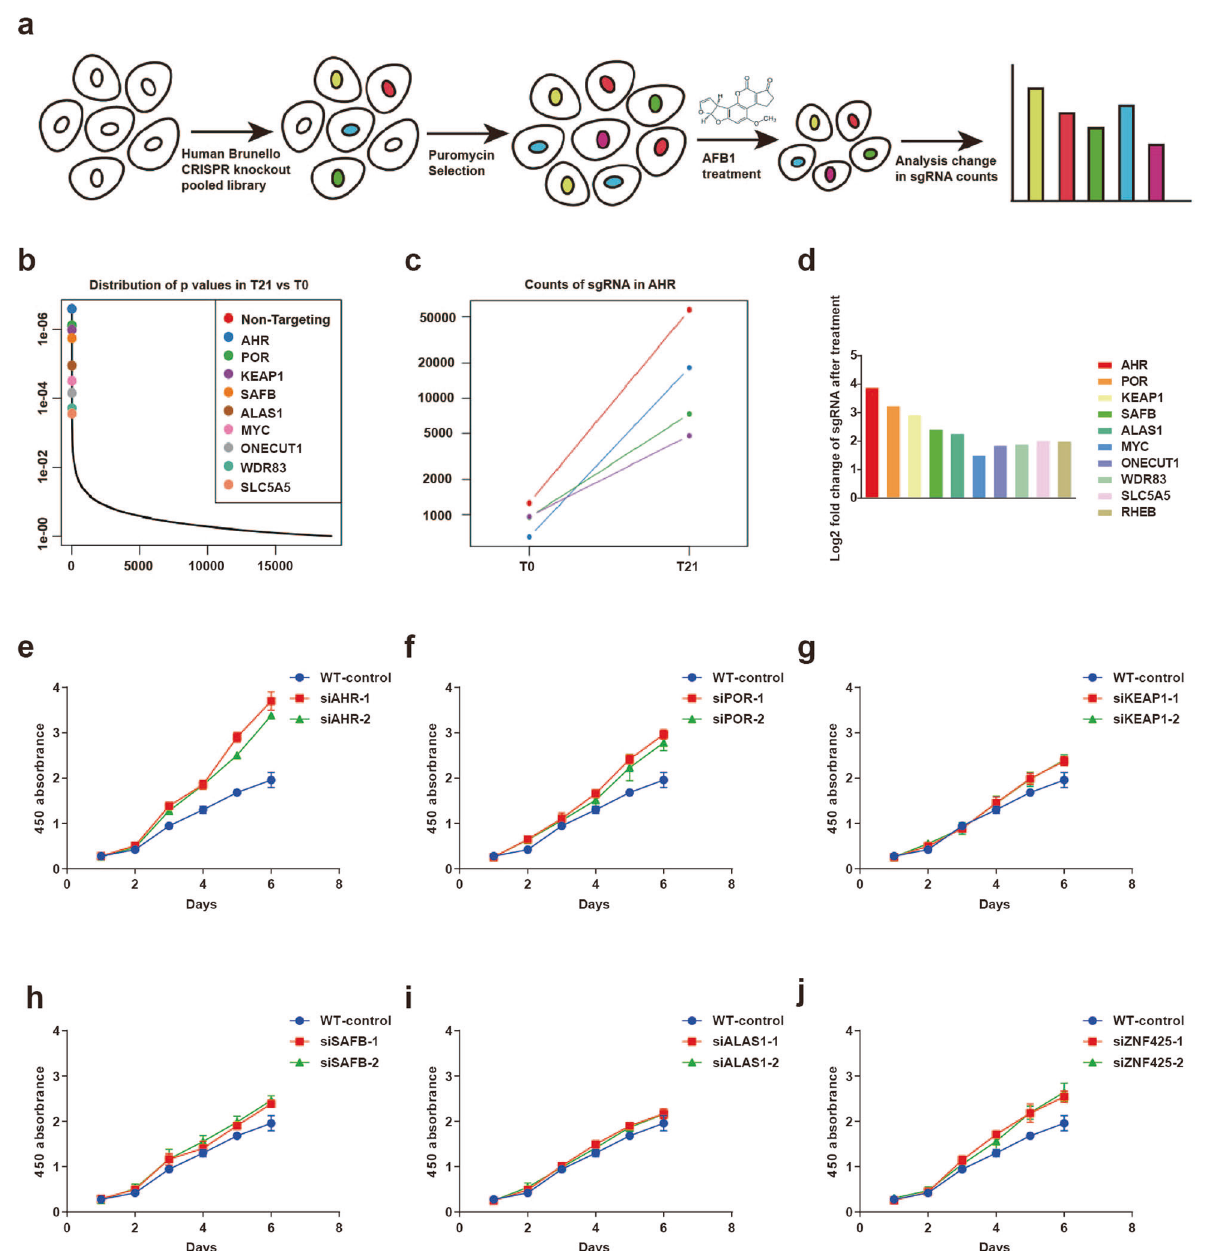
Fig. 1 Genome-wide CRISPR-Cas9 screen identi fi es genes essential for AFB1-induced cell death. a Schematic of CRISPR-Cas9 function screens. b Genes signi fi cantly enriched after six rounds of AFB1 treatment were identi fi ed through analysis of sequencing results in the MAGeCK program. c Change in sgRNA counts after AFB1 treatment relative to untreated cells. d Fold change of the sgRNA targeting candidate genes (only the top ten genes are shown). e – j Cell viability measured with the CCK8 assay for PLC/PFR/5 cells in 20 µM AFB1 with knockdown of e AHR , f POR , g KEAP1 , h SAFB , i ALAS1 , and j